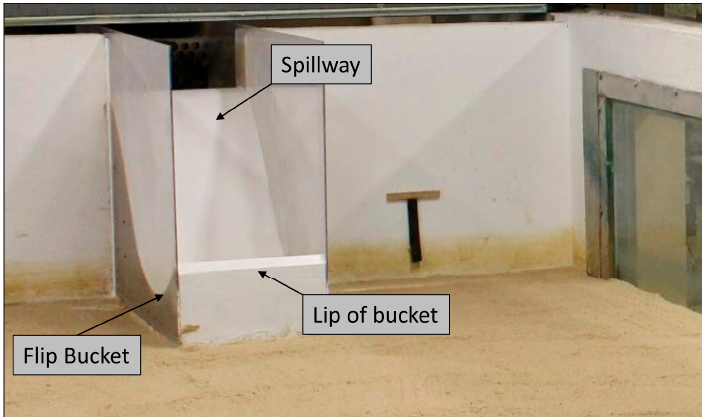
Figure 5. Testing set-up. ( a ) Side view; ( b ) Plan view.